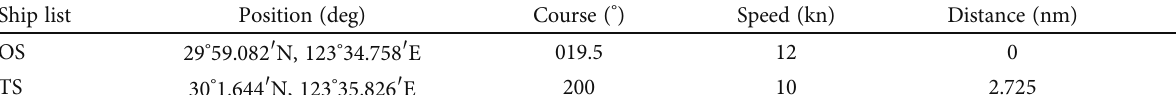
Table 6: Initial information of the ships for head-on situation.